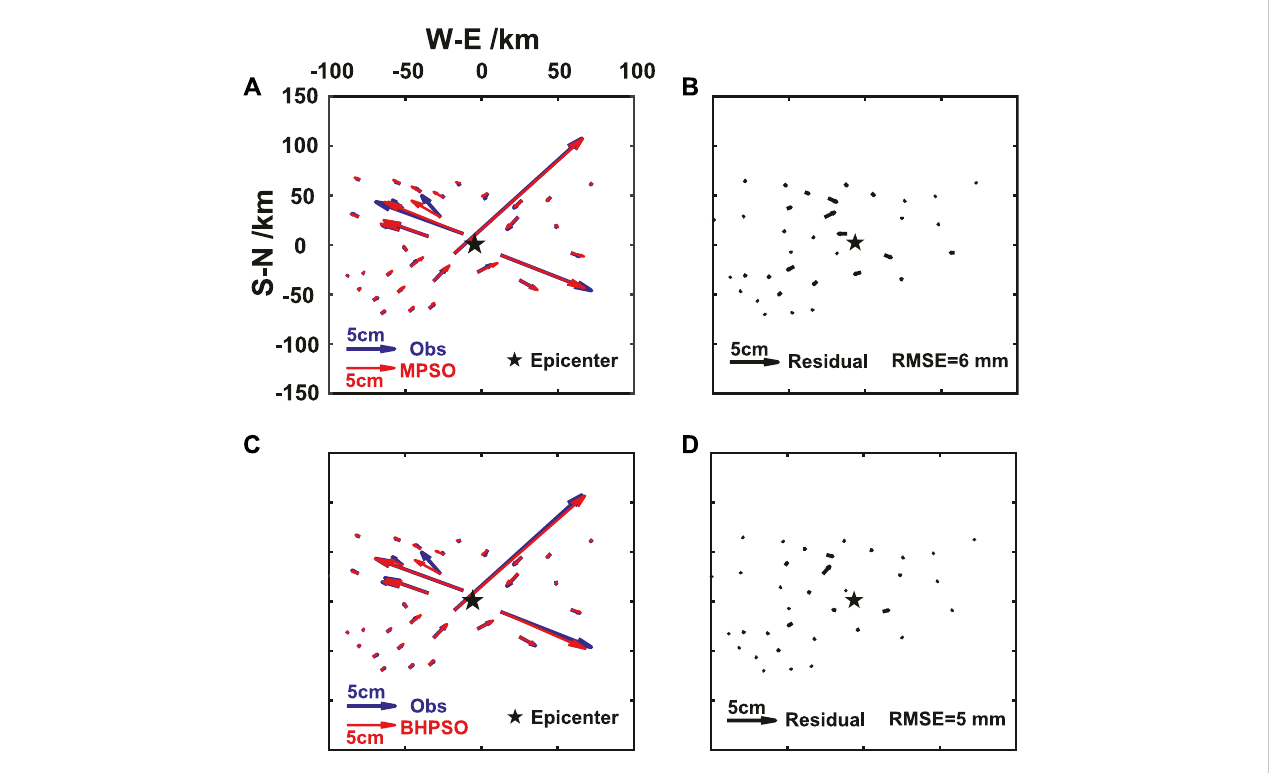
The comparisons of surface horizontal deformation (GPS data) of the observed and the Okada model results by using fault parameters given by the inversed from MPSO and BHPSOmethods in Table 5. The surface horizontal deformation obtained by observed and MPSO method (A) , observed and BHPSO method (C) . The residual of surface horizontal deformation between the results of observed and MPSO method (B) , observed and BHPSO method (D) . Here, weonlyshowthehorizontaldisplacementandresidualsbecausetheverticaldisplacementisconsiderablysmallerthanthehorizontaldisplacement.The blue arrow and its length represent the displacement from GPS data, the red arrow and its length represent the inversion results from MPSO or BHPSO. The black arrow and its length represent the residuals.